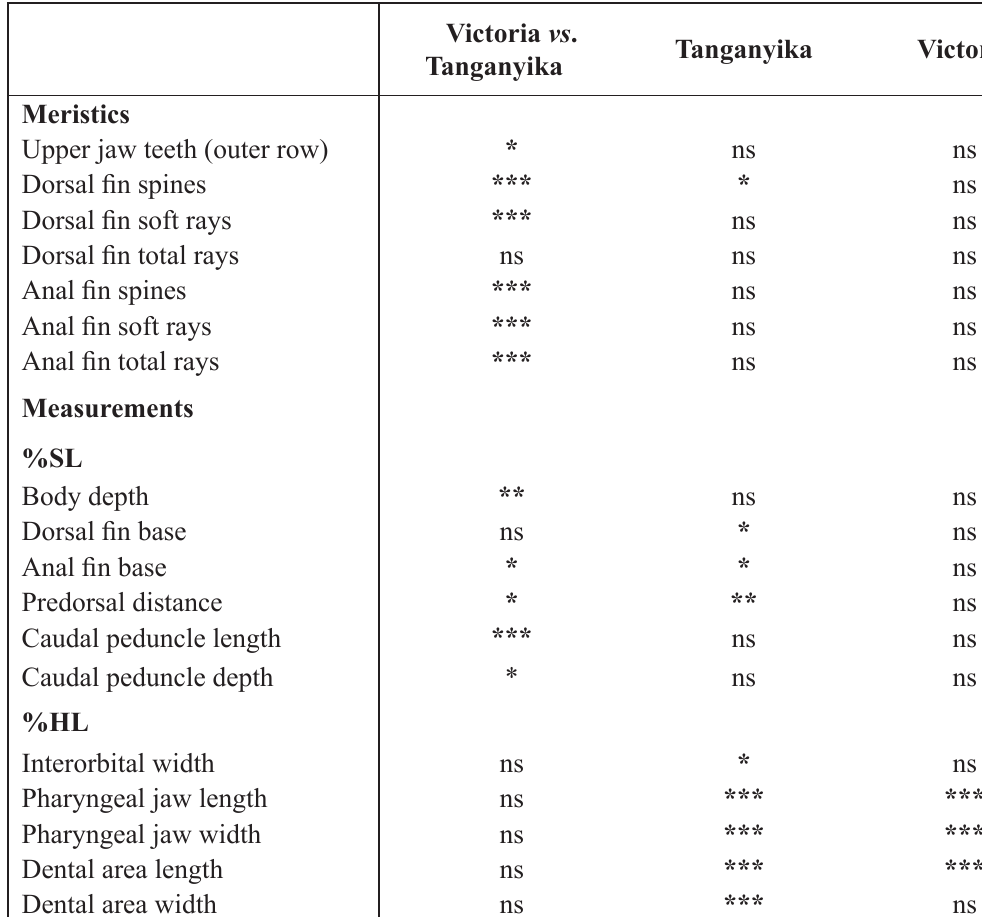
Table 3 . Results from Mann-Whitney U-tests, comparing meristics and measurements of specimens of a similar size class. Three comparisons were made (1) between the Lake Victoria (n = 27) and Tanganyika (n = 80) systems [43.7-94.5 mm SL; p = 0.316], (2) within the Tanganyika system between the Rusizi (n = 43) and the Malagarazi (n = 39) [43.7-111.3 mm SL; p = 0.464] and (3) within the Victoria system between lakes Victoria and Kyoga (n = 12) and the remaining basins (lakes Edward, George, Kayanza, Nabugabo and Nakavali; n = 16) [76.1-137.5 mm SL; p = 0.631]. Only variables with a significant difference are listed. Significant levels are based on Bonferroni corrected values as follows: ns = not significant; * = significant, p ≤ 0.05; ** = highly significant, p ≤ 0.01; *** = very highly significant, p ≤ 0.001.